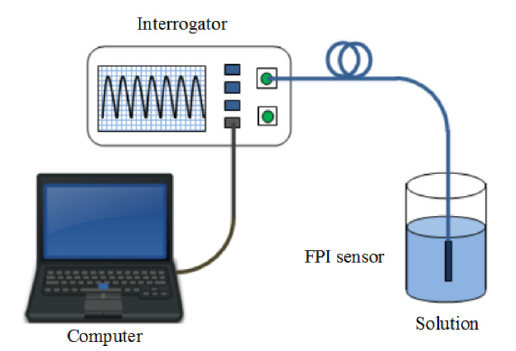
Fig. 4 Experimental setup for RI